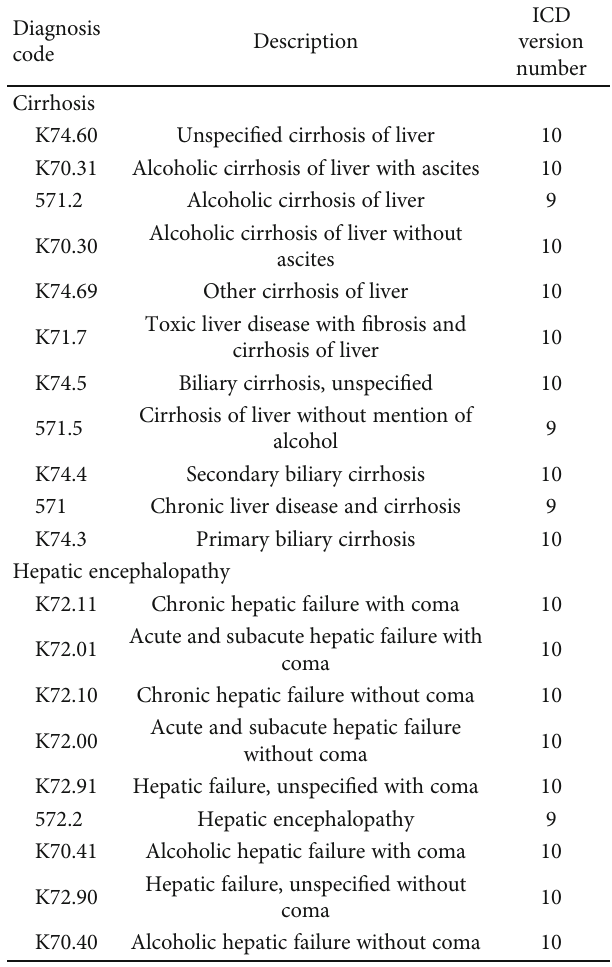
Table 1: Identifying ICD-9-CM and ICD-10-CM